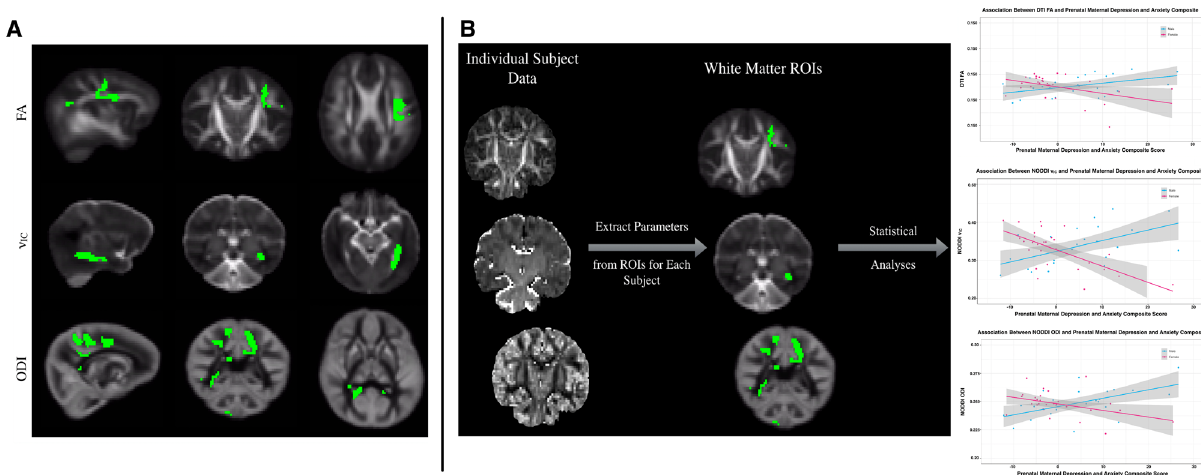
Figure 1. ( A ) Representative sagittal, coronal, and axial sections of WM regions previously found to be differentially associated with maternal depression and anxiety symptoms during mid-late pregnancy. DTI FA associations were observed in regions of the corona radiata and superior longitudinal fasciculus, among others; NODDI ν IC associations were found in the sagittal stratum and white matter adjacent to the hippocampus; and NODDI ODI associations were observed in areas of posterior thalamic radiations, splenium of the corpus callosum, among others 8 . ( B ) Schematic illustrating extraction of WM microstructural measures from WM regions. Mean FA, ν IC , and ODI were extracted from the respective WM regions for each subject and used in subsequent formed when the infant was 1-month of age during natural, nonsedated sleep 34,35,40 . Measures taken for success- ful image acquisition included acoustic noise reduction via fitting a foam insert inside the MRI scanner bore, utilizing ear plugs and MiniMuff (Natus Medical Incorporated) neonatal noise-attenuating ear covers, playing white noise through electrodynamic headphones (MR Confon, Germany) throughout the image acquisition, and limiting the MRI scanner slew rates. To help reduce motion throughout the scan, we swaddled each child using an infant MedVac vacuum immobilization bag and placed foam cushions around the head. Additional details about MRI acquisition have been previously described 8,34–36,40 . A 10-min multi-shell diffusion imaging protocol was used to acquire 69 diffusion weighted images (DWIs), with 9/18/36 diffusion-encoding gradient directions at b = 350/800/1500 s/mm 2 , respectively, and 6 with no (b = 0 s/mm 2 ) diffusion weighting. Additional imaging criteria consisted of the following: image resolution 2 × 2 × 2 mm; repetition time, 8400 ms; and echo time, 94 ms. DWI data were manually inspected for image artifacts, eddy current and motion corrected 41 , and skull-stripped (http:// afni. nimh. nih. gov/ pub/ dist/ doc/ progr am_ help/ 3dSku llStr ip. html). Diffusion tensor imaging (DTI 42 ) and Neurite Orientation Dispersion and Density (NODDI 43 ) parameters were estimated and registered to a common, population specific template. Additional details regarding the diffusion image acquisition and processing are described elsewhere 8,34 .